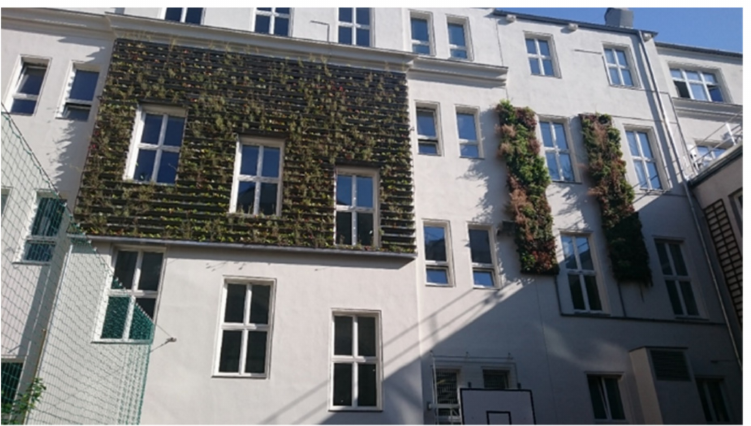
Figure 1. Studied greening systems; System A—aluminum troughs ( left ), System B—cassette sys- tem ( right